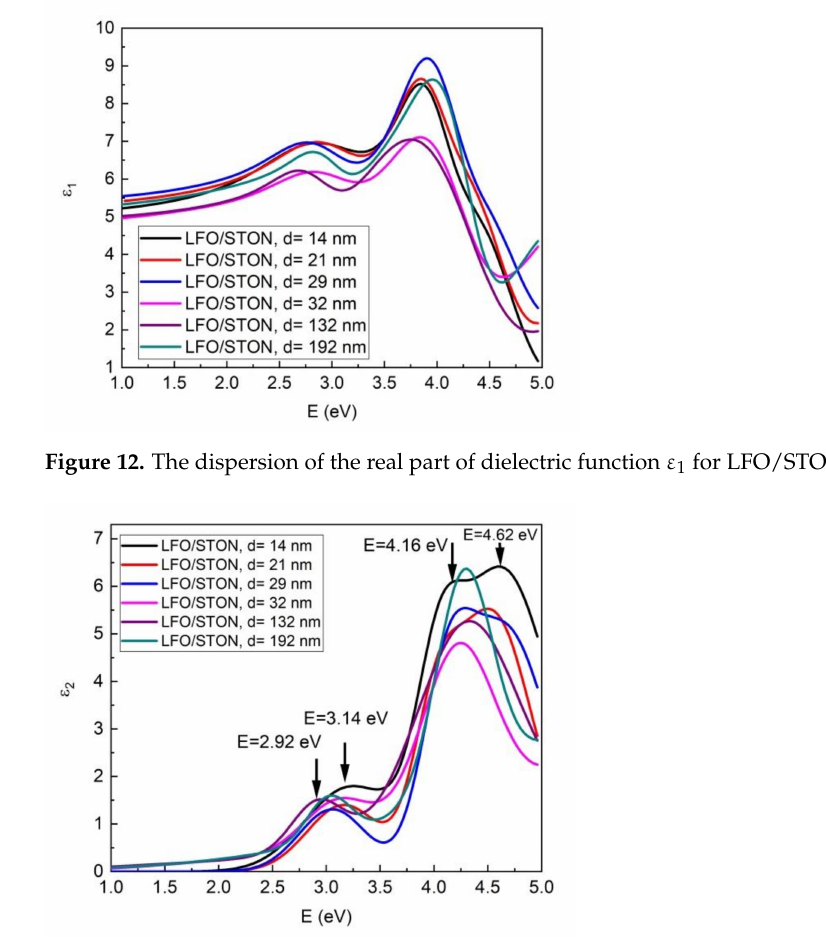
Figure 13. The dispersion of the imaginary part of dielectric function ε 2 for LFO/STON thin